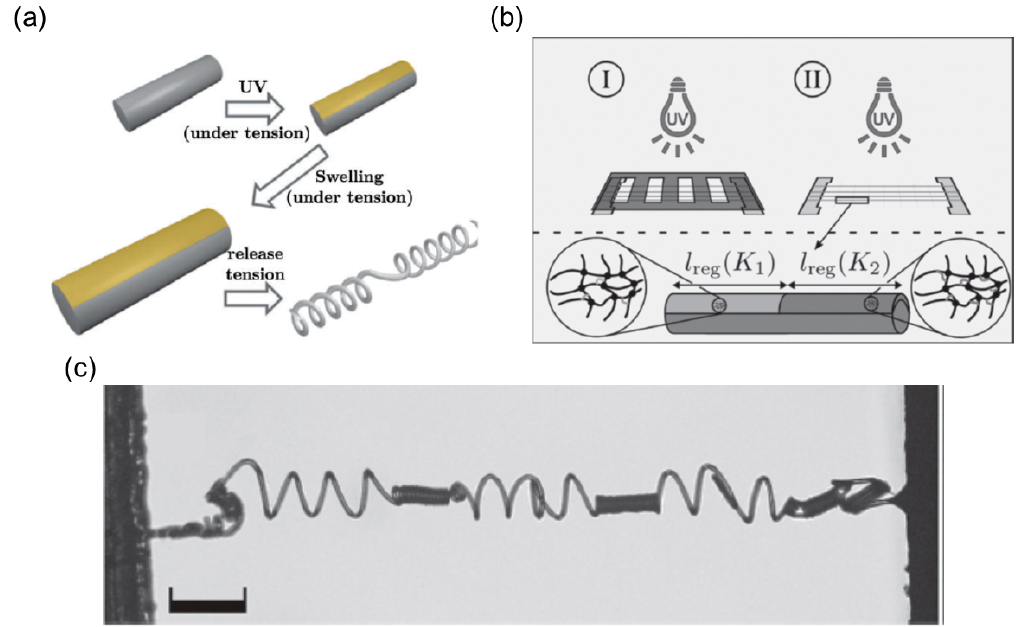
Figure 18. The electrospun fibers with further UV crosslinking. ( a ) Schematic illustration of the heterogenous structure induced by UV irradiation; ( b ) Schematic illustration of the two-step UV crosslinking in generating regions with different intrinsic curvatures; ( c ) Polarized light microscopy (POM) image of electrospun fibers separated by high-intrinsic-curvature regions and low-intrinsic-curvature regions. ( a ) is from [132], reprinted with permission, copyright © 2013, John Wiley and Sons; ( b , c ) are from [133], reprinted with permission, copyright © 2017, John Wiley and Sons.